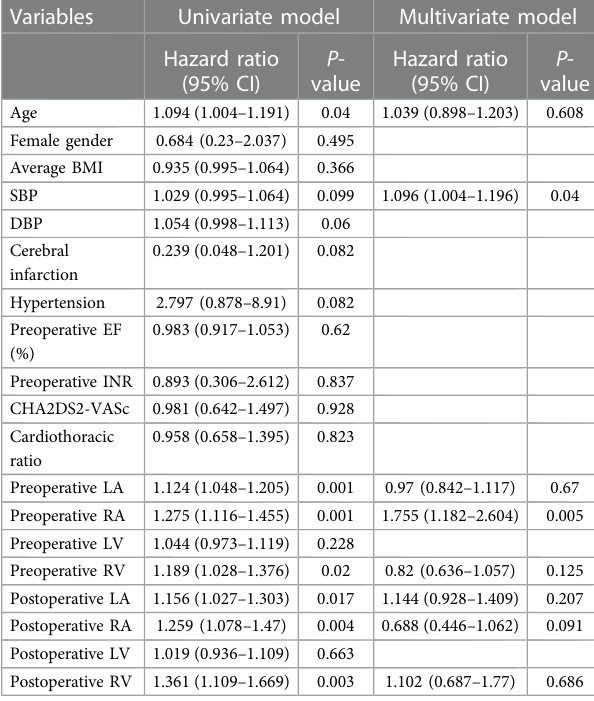
TABLE 4 Predictors of AF recurrence following AVR.